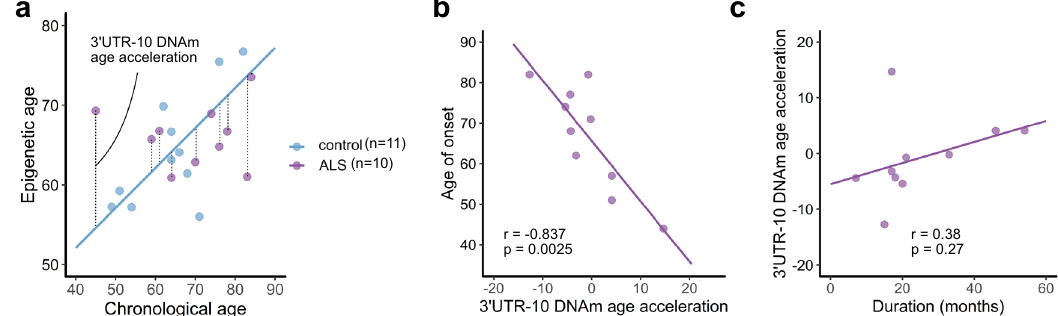
Fig. 8 Association between DNA methylation age acceleration and the clinical features in ALS. a “ Epigenetic age ” is estimated based on the regression coef fi cient calculated from the chronological age and the DNA methylation percentages at TARDBP 3 ′ UTR CpG 10 in the control motor cortex (11 controls). The difference between the epigenetic age and the linear-regression model is de fi ned as “ DNA methylation age acceleration ” in the ALS cases. Ten ALS patients were included in the analysis in relation to the clinical features. b Scatterplot showing the age at disease onset according to DNA methylation age acceleration at 3 ′ UTR CpG 10. c Scatterplot showing the acceleration of the DNA methylation age at 3 ′ UTR CpG 10 according to the disease duration. Pearson ’ s correlation